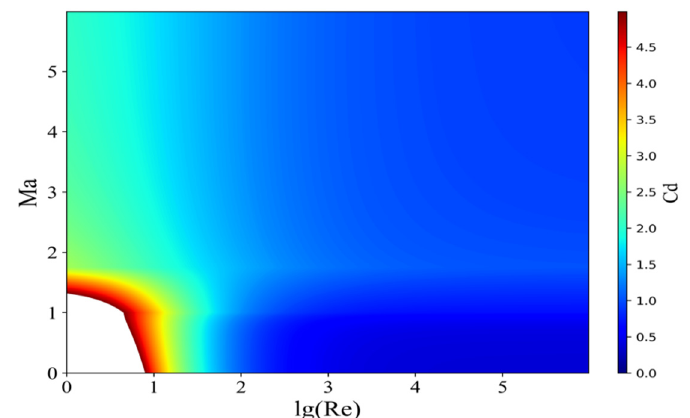
Figure 1. Drag coefficient summarized by Henderson. (Ma is Mach number, Re is Reynolds number, Figure 1. Drag coe ffi cient summarized by Henderson. (Ma is Mach number, Re is Reynolds number, and Cd is drag coefficient). and Cd is drag coe ffi